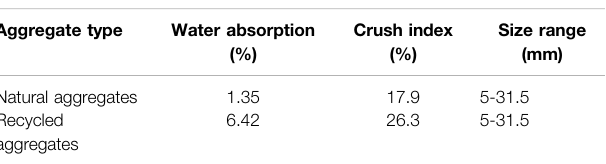
TABLE 2 | Properties of coarse aggregates